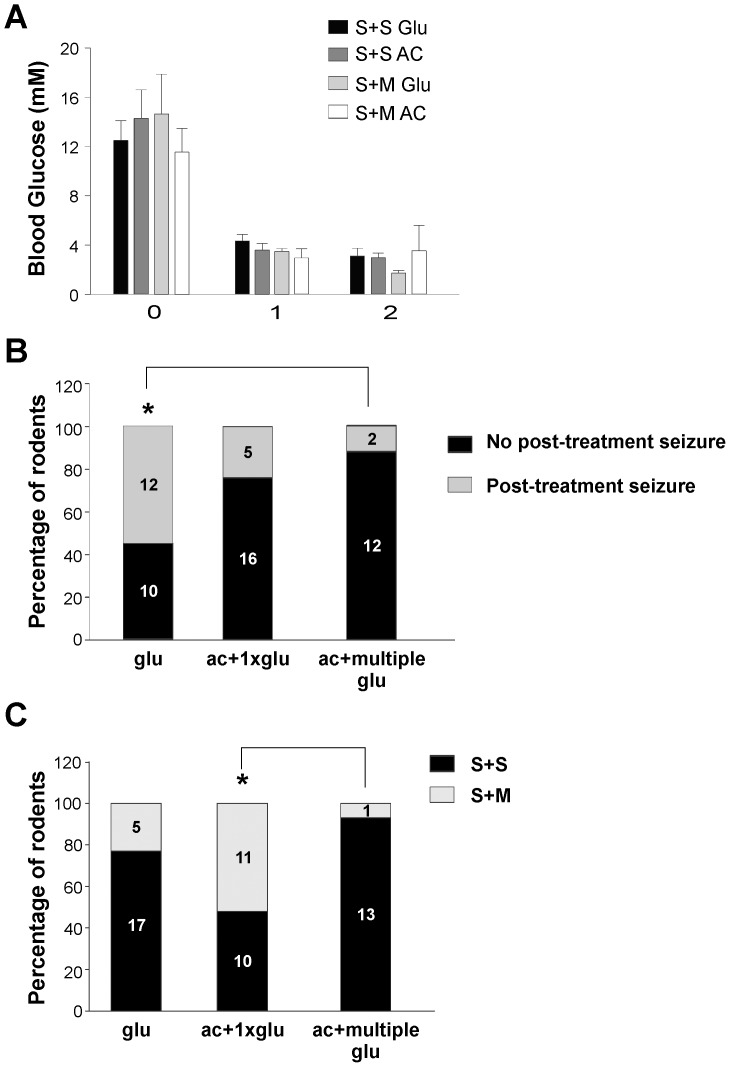
Efficacy of treatment strategies (see Table 1) in preventing subsequent seizures and mortality in STZ rats.
A: BG decrease is not significantly different in seizing animals regardless of treatment; glu: seizure+ survival (S+S Glu), ac+1xglu: S+S AC, glu: seizure + mortality (S+M Glu), ac+1xglu: S+M AC (Table 4). B: No significant difference in the incidence of seizures post-treatment in ac+1xglu: 24% (n = 5/21) compared with glu: 55% (n = 12/22) (p<0.05). (*) Significantly lower incidence of seizures post-treatment in ac+multiple glu: 15% (n = 2/14) compared with glu: 55% (n = 12/22) (p<0.02) C: (*) Significantly higher survival rate in ac+multiple glu: 93% (n = 1/14) compared with ac+1xglu: 48% (n = 10/21) (p<0.02). No significant difference in survival rate between ac+multiple glu: 93% (n = 13/14) and glu: 77% (n = 17/22).